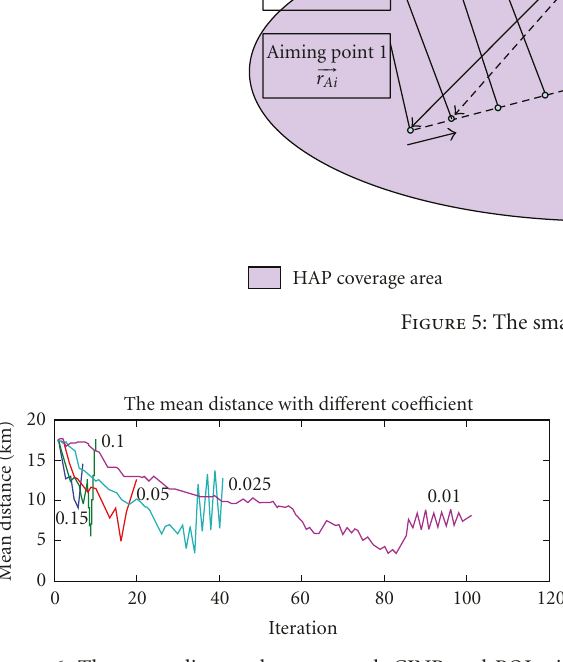
Figure 6: The mean distance between peak CINR and POI with di ff erent coe ffi cients in a small step